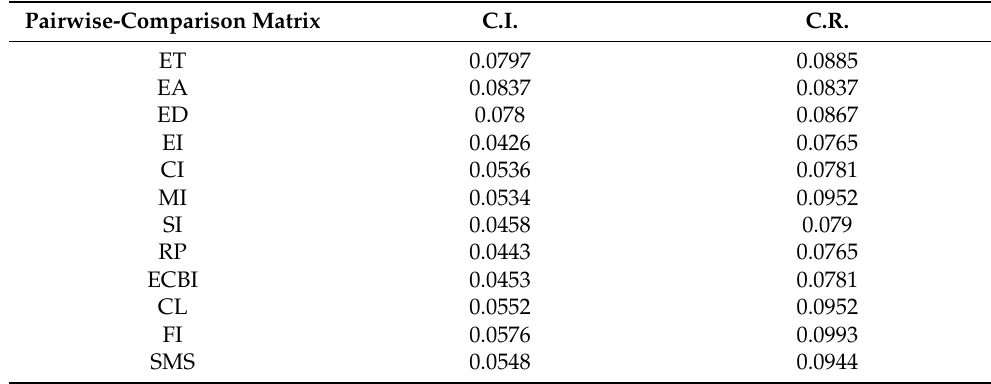
Table 4. The entire commonalities of each assessed criterion, sub-criterion, and